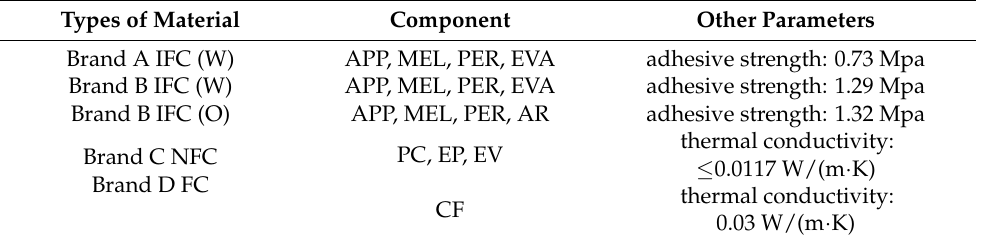
Table 2. Parameters of the